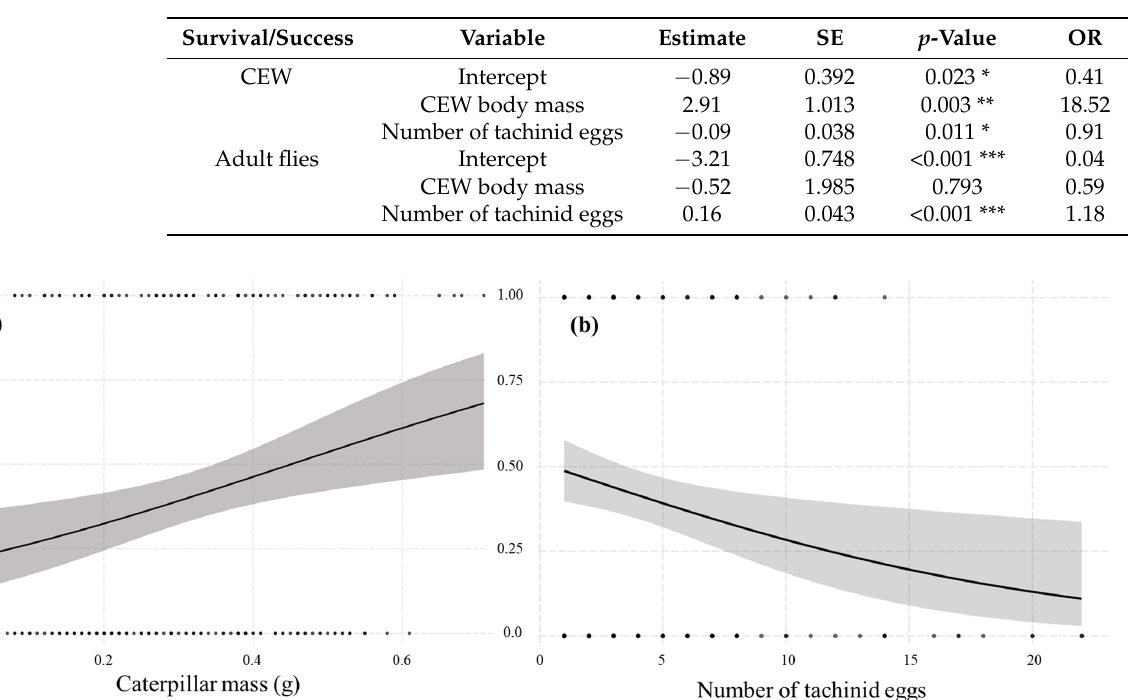
Table 3. Summary of the logistic regression models explaining the survival of CEW and success of Table 2. Mortality of parasitized caterpillars over sampling events. N corresponds to the number of tachinid flies (emergence of adults). SE = standard error, OR = odds ratio. Significant at 0.01 (*), parasitized caterpillars collected at each date. 0.001 (**), <0.001 (***).